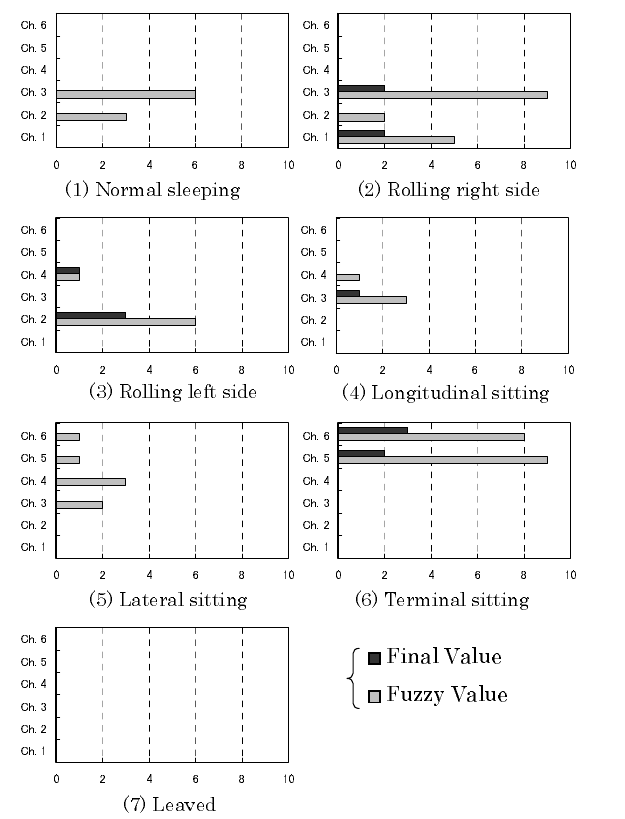
Figure 8. Frequency distributions of fuzzy and definite values in respective behavior patterns. Table 3. Thresholds of fuzzy values and final values in